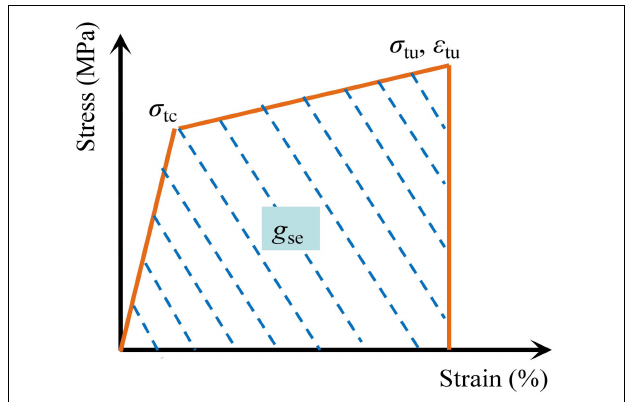
significant peaks could be observed: the first peak is around 200 ◦ C, mainly related to the dehydration of ettringite; the second peak around 450 ◦ C is the dehydroxylation of Ca(OH) 2 ; and the